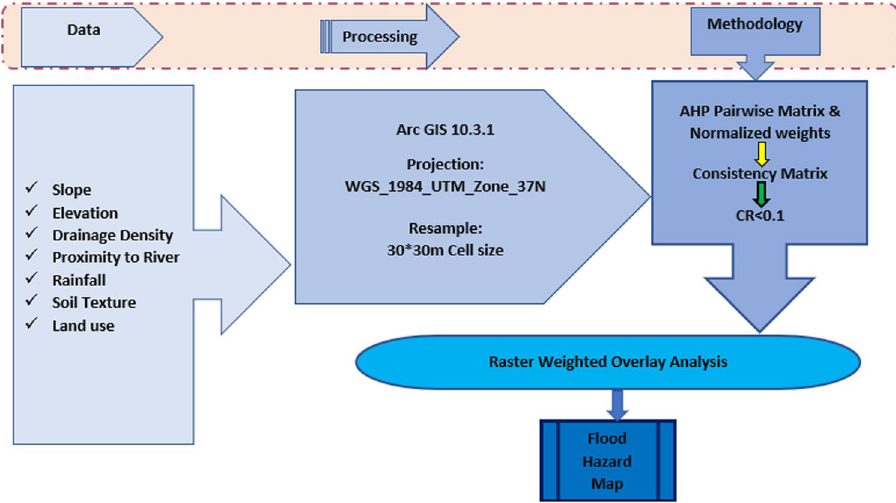
Figure 2 Work flow of flood